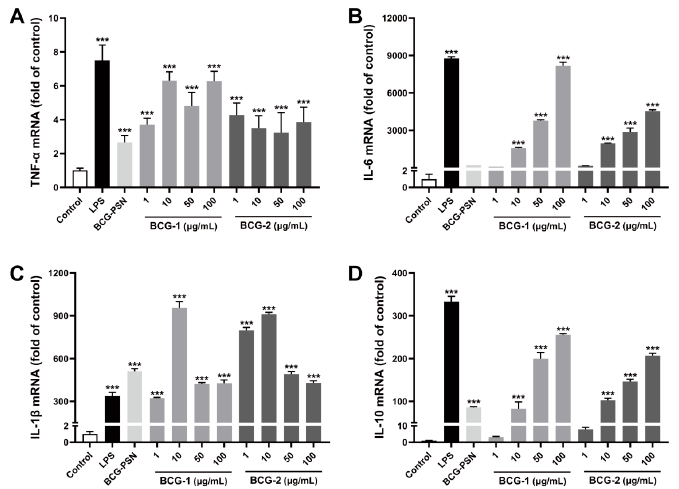
Figure 7. Effects of LPS, BCG-PSN, BCG-1, and BCG-2 on the mRNA expressions of TNF- α ( A ), IL- 6 ( B ), IL-1 β ( C ), IL-10 ( D ) in the RAW 264.7 cells. LPS was at 100 ng/mL, BCG-PSN was at 87.5 μ g/mL. *** p < 0.001 vs. control, one-way ANOVA, Dunnett’s multiple comparisons test.